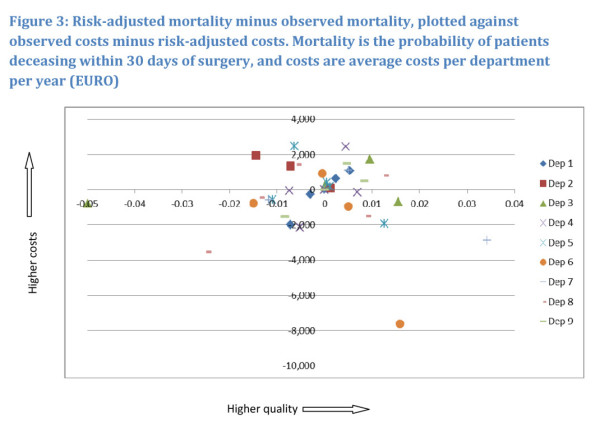
Risk-adjusted mortality minus observed mortality, plotted against
observed costs minus risk-adjusted costs. Mortality is the
probability of patients deceasing within 30 days of surgery, and costs are
average costs per department per year (EURO).